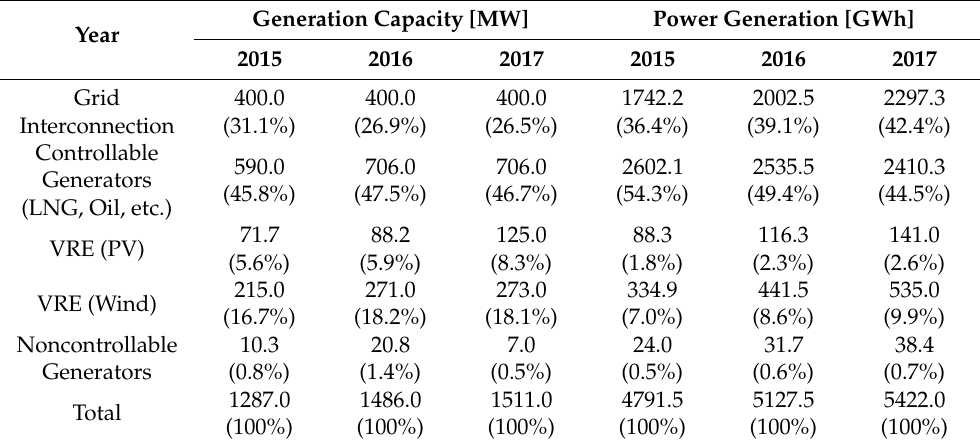
Table 1. Generation capacity and power generation on Jeju Island from 2015 to 2017.